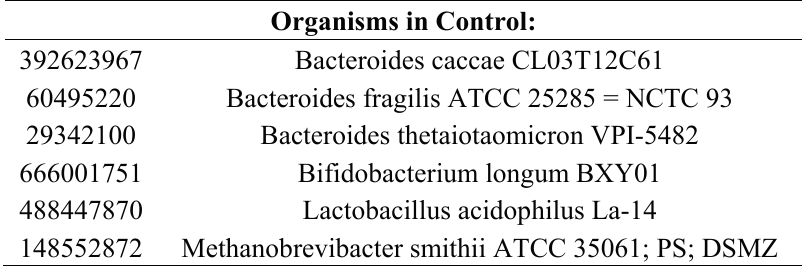
Table 2. Selected organisms for Query 3 of the Metabolomics